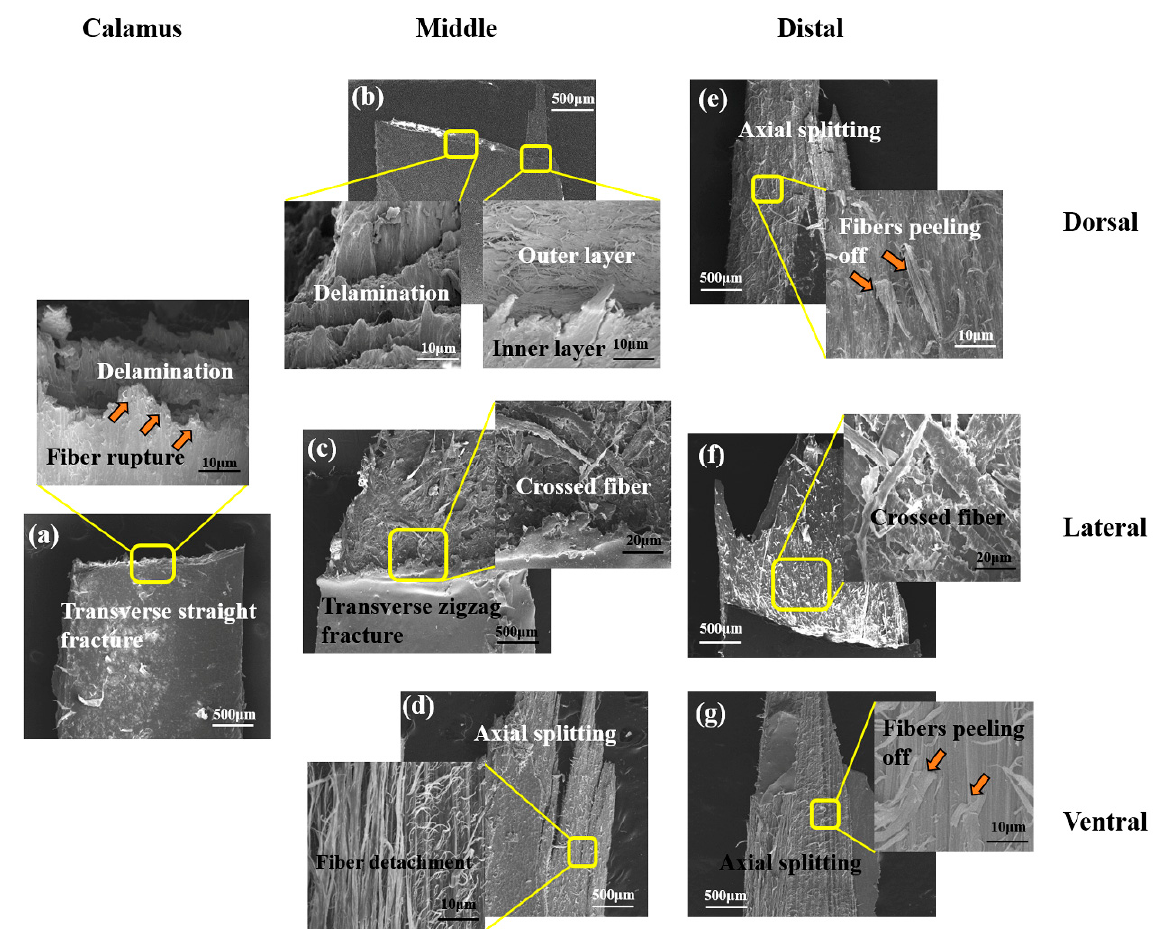
Figure 4. Typical fracture morphologies of stretched samples: ( a ) calamus cortex; ( b – d ) middle cortex through dorsal, lateral and ventral, respectively; ( e – g ) distal cortex through dorsal, lateral and ventral, respectively.